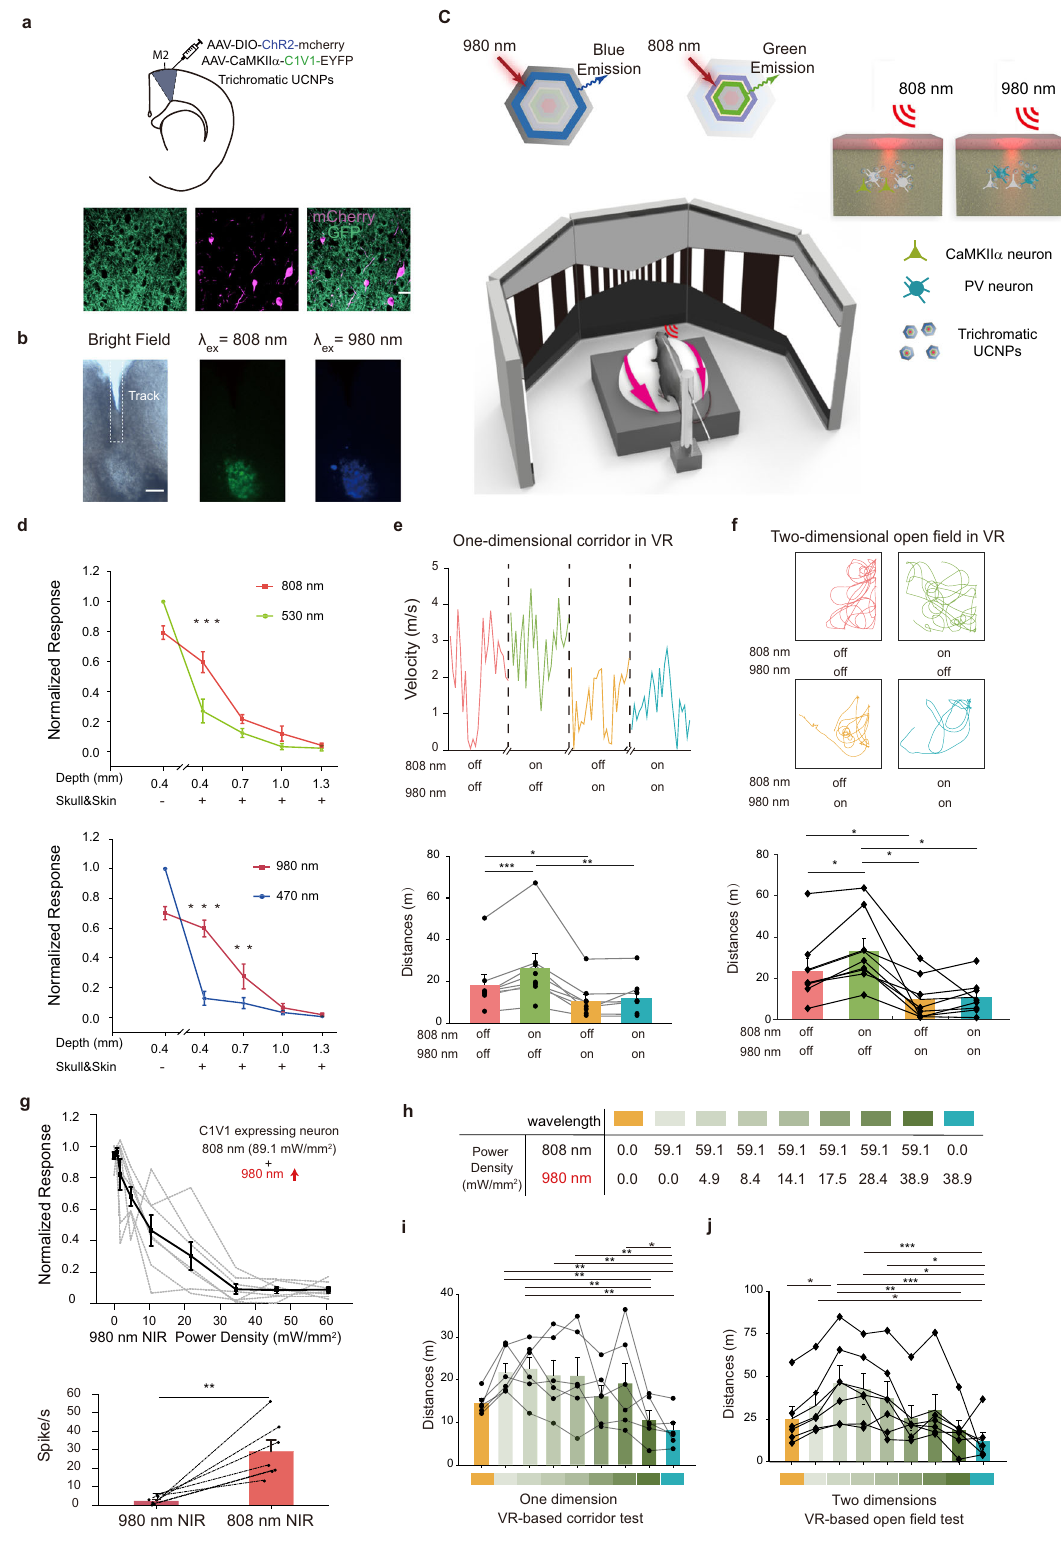
absorbing 980 nm photons. In our structure, different types of For the design of the UCNPs, previous reports have demon- sensitizers are used, namely Er 3 + /Yb 3 + /Nd 3 + . To construct strated two-color orthogonal blue/green upconversion with sen- sitizer Yb 3 + /Nd 3 + . In those previous nanostructures, both core responsive trichromatic emission, we investigated the dissipation and shell have the same sensitizer Yb 3 + which can be excited by process between sensitizer of erbium and ytterbium as well as erbium and neodymium and found that energy extraction 980 nm light. The responsive dichromatic emission was realized induced dissipation in the outer shell is a critical factor for by a higher doping concentration of Yb 3 + in the outer layers for NATURE COMMUNICATIONS| (2021) 12:5662